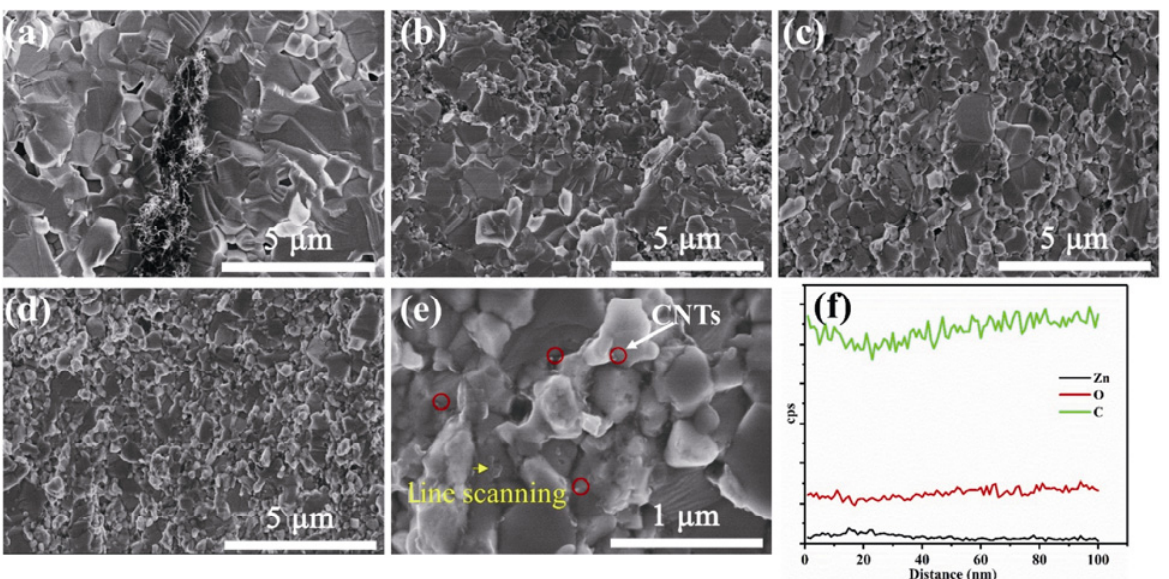
Fig. 4 SEM images of fractured surfaces of ZnO bulk composites: (a) 2.0% CNTs/ZnO, (b) 1.5% Ni–CNTs/ZnO, (c) 1.75% Ni–CNTs/ZnO, (d) 2.0% Ni–CNTs/ZnO, (e) high-magnification image of 2.0% Ni–CNTs/ZnO, and (f) line